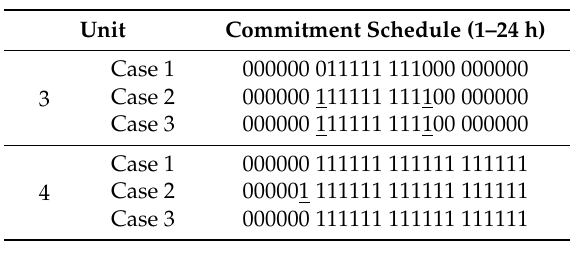
Table 3. Unit commitment schedules.